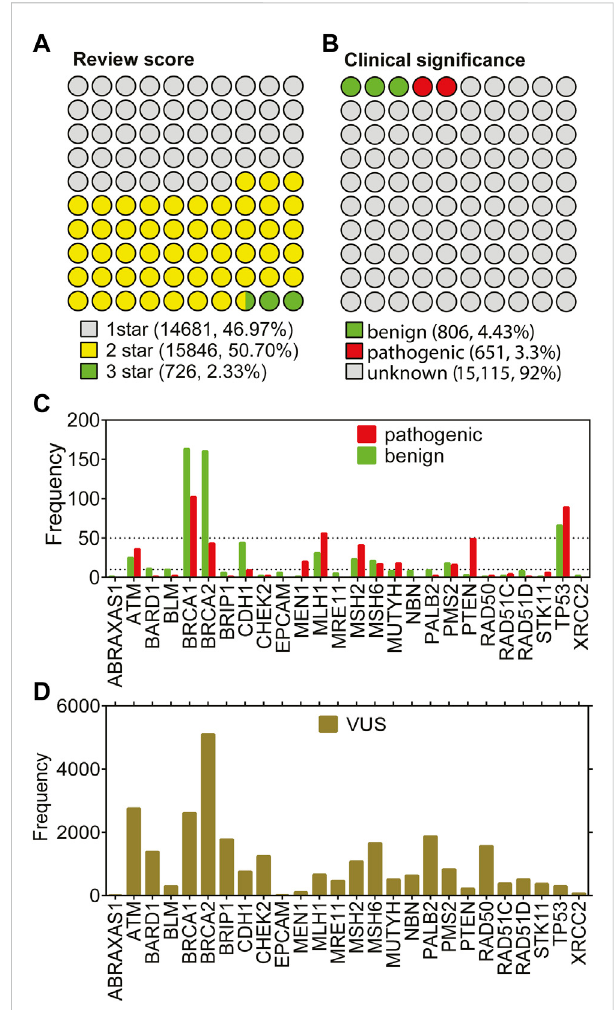
Missense variations from 26 genes in ClinVar. (A) shows the distributions based on annotation scores. (B) shows the distribution of clinical signi fi cance labels of the variants with at least 2 review scores. (C) shows the gene-distribution of benign and pathogenic variants from (B) First tick marks the frequency value of 5. (D) shows the distribution of VUS labels across